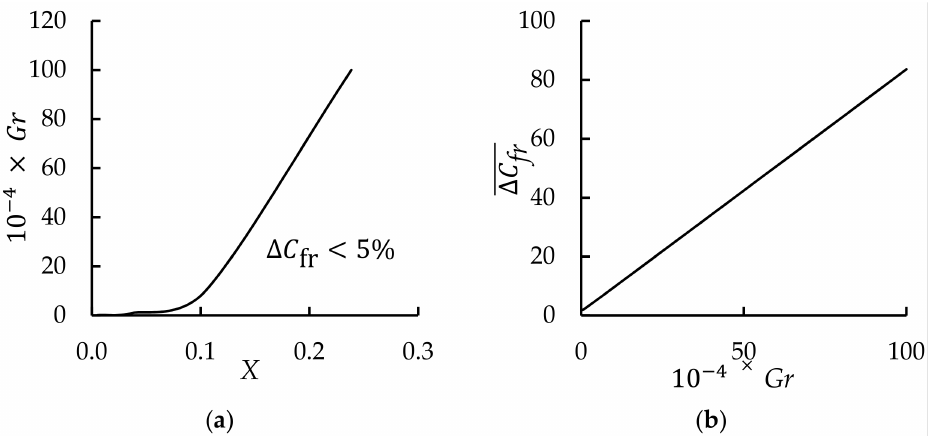
Figure 12. ( a ) Critical Grashof number at various positions along the sheet when ∆ ≤ 5% and ( b ) the average error corresponding with the Grashof number for Re = 400, Pr = 6.2, Le = 10, Nb = Nt = Nr = Rb = Ω = 0.1, and Pe = Lb =